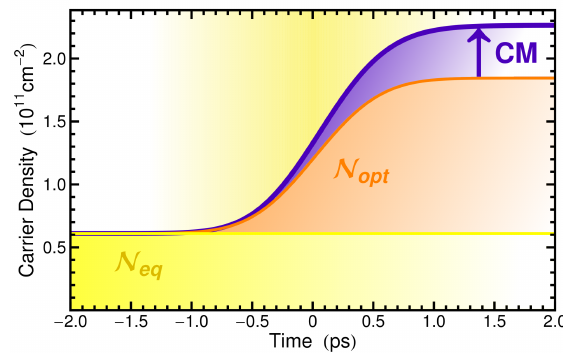
Figure 18: Carrier multiplication. Temporal evolution of the carrier density including the optical excitation as well as Coulomb scatter- ing N (purple line), the carrier density in the absence of Coulomb scattering N opt (orange line), and the constant equilibrium carrier density N eq (yellow line) for the excitation scheme sketched in Fig. 16a. The yellow region in the backgrounds illustrates the optical excitation. Eflcient Auger scattering leads to a carrier multiplica- tion (CM) of approximately 1.3 . The Figure is taken from Ref. [73] Copyright (2014) by Nature Publishing